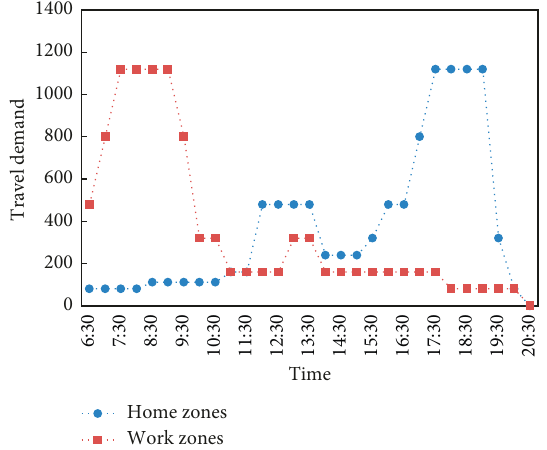
Figure 15: Distribution of travel demand from home and work zones.